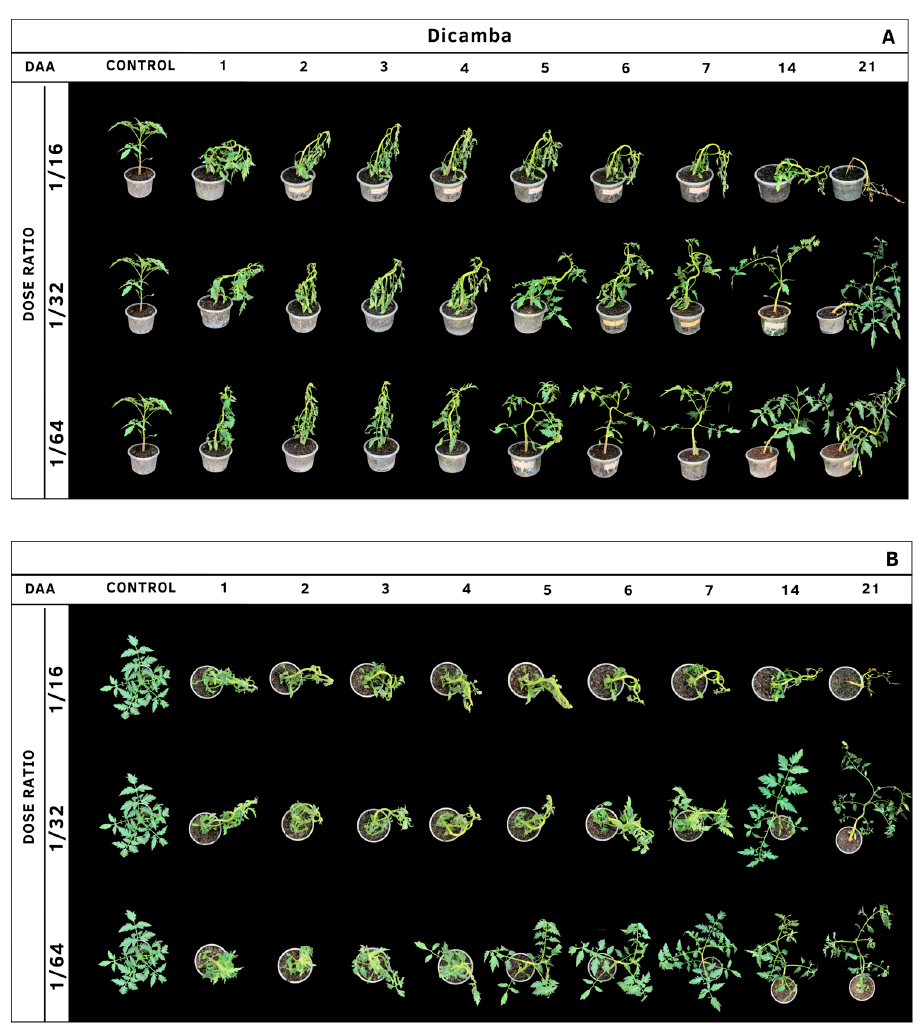
Figure 3. Symptoms evolution in tomato plants due to simulated dicamba drift at dose ratios 1/16D, 1/32D, and 1/64D (45, 22.5, and 11.25 g a.e. ha − 1 , respectively) of the recommended dose (D). Evaluations were made from 1 to 7, 14, and 21 days after application (DAA). Front view ( A ) and top view ( B ) of tomato plants affected by simulated drift.